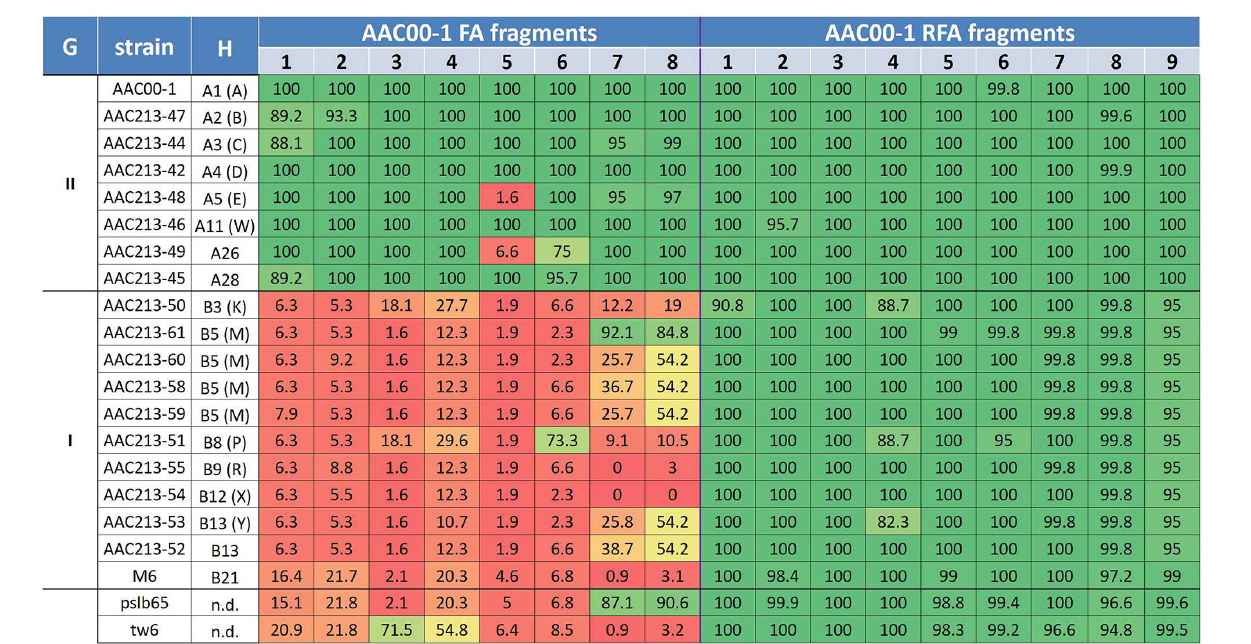
for fragments FA5–FA8. However, there were a few